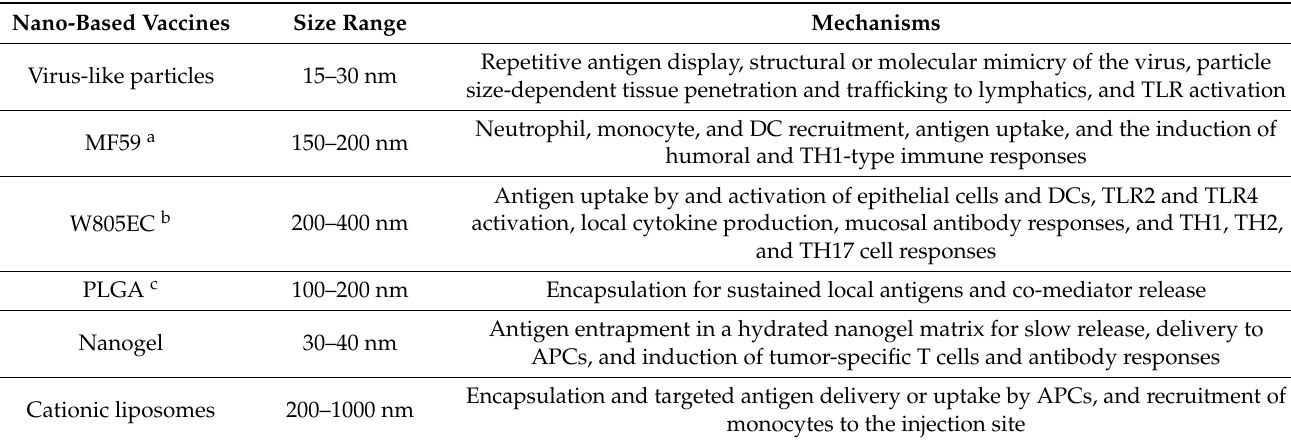
Table 3. Some examples of nano-based